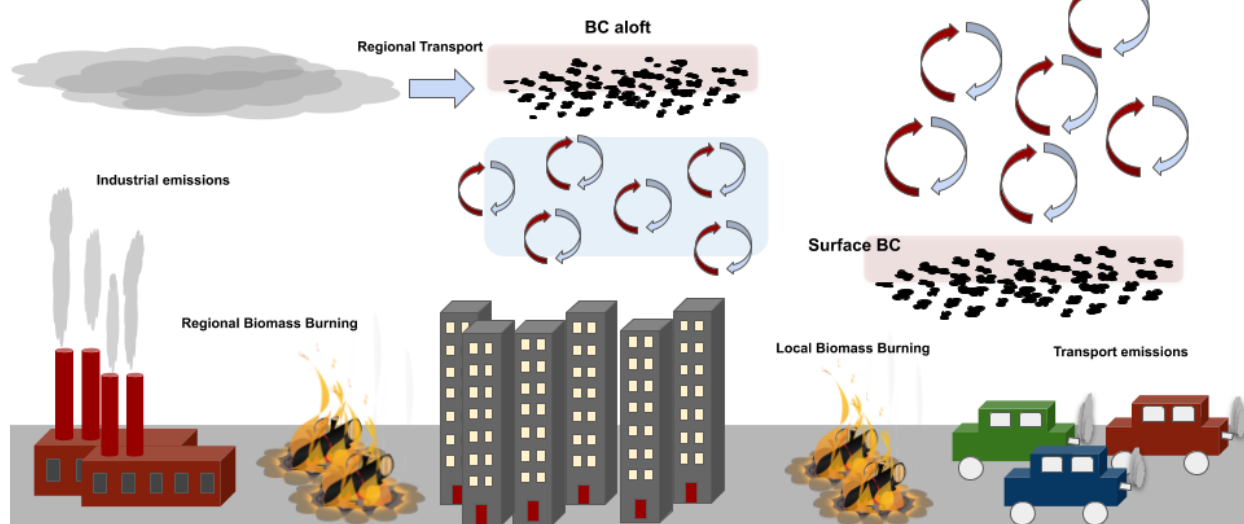
Figure 1. Schematic showing some of the sources of BC in Beijing, which include industrial emissions, regional and local biomass burning and emissions from transport, as well as outlining the main concepts presented in this paper of the influence of BC aloft and BC within the PBL on PBL